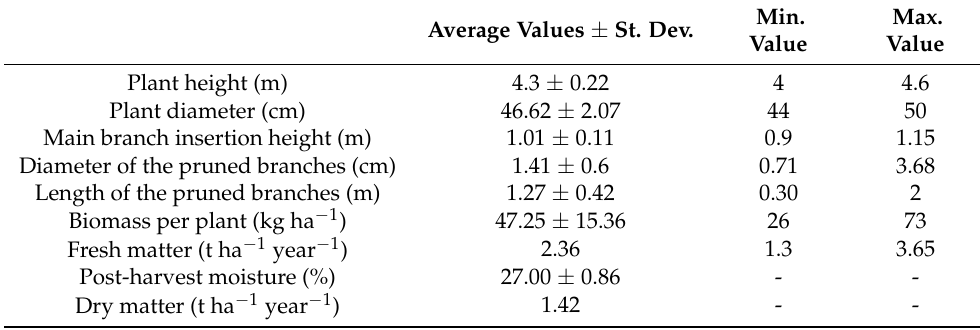
Table 1. Morphometric values of plants and dimensional characteristics of olive groves pruning. Min. Max. Average Values ± St. Dev. Value Value Plant height (m) 4.3 ± 0.22 4 4.6 Plant diameter (cm) 46.62 ± 2.07 44 50 Main branch insertion height (m) 1.01 ± 0.11 0.9 1.15 Diameter of the pruned branches (cm) 1.41 ± 0.6 0.71 3.68 Length of the pruned branches (m) 1.27 ± 0.42 0.30 2 Biomass per plant (kg ha − 1 ) 47.25 ± 15.36 26 73 Fresh matter (t ha − 1 year − 1 ) 2.36 1.3 3.65 Post-harvest moisture (%) 27.00 ± 0.86 - - Dry matter (t ha − 1 year − 1 ) 1.42 -